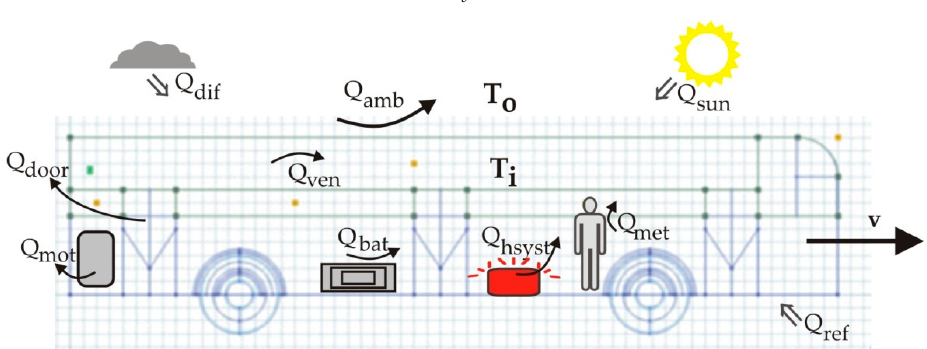
Figure 1. Schematic representation of heat loads: a model for a typical electric bus.